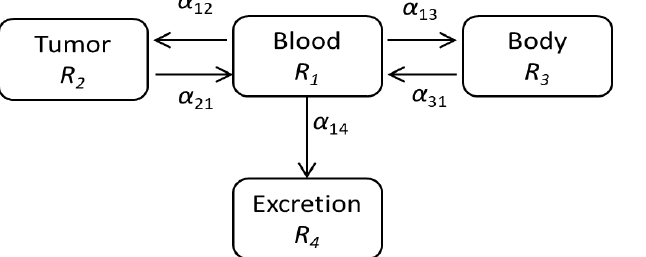
Figure 1. The drug delivery model describing the behavior of 211 At in mouse. The radiating material 211 At is delivered to the tumor and other parts of the body through blood and eventually is excreted from body.